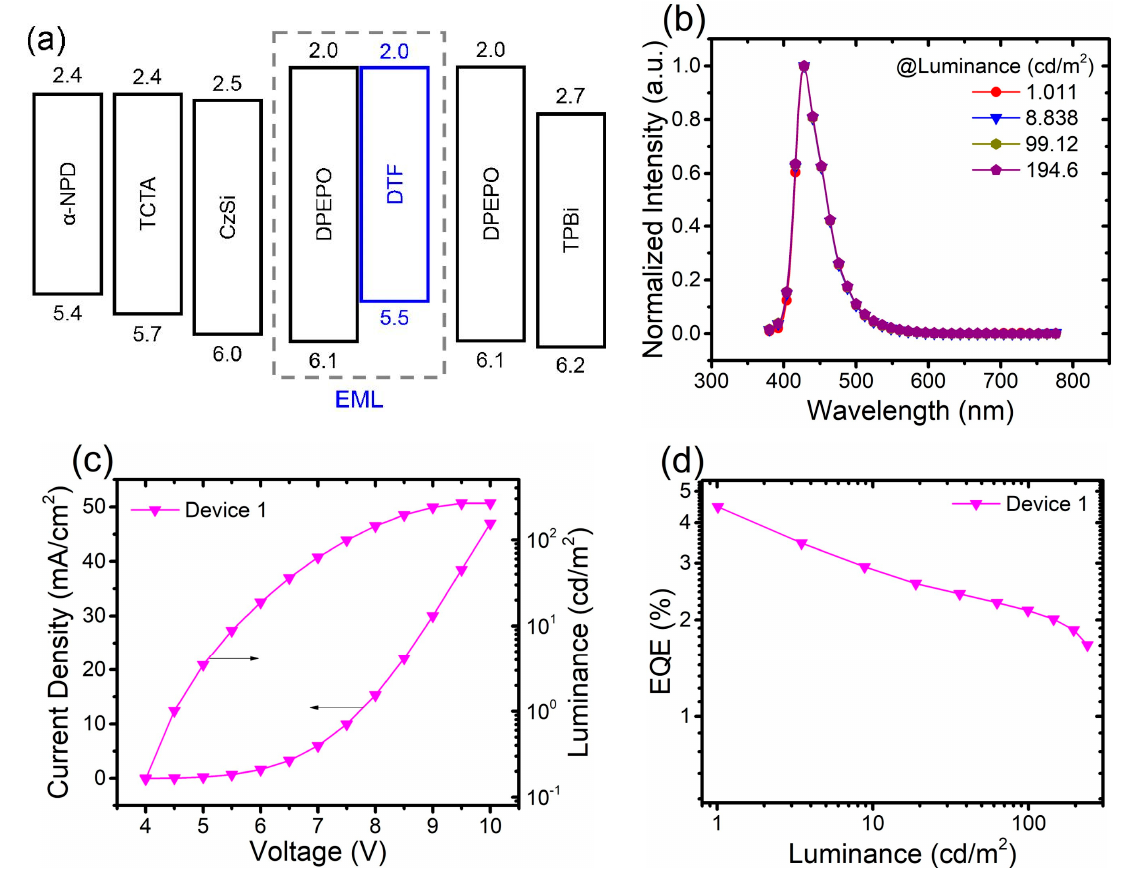
Figure 4. Device 1: ( a ) structure and HOMO, LUMO energy levels (in eV); ( b ) EL spectra; ( c ) current density-voltage-luminance (J-V-L) plots; and ( d ) EQE curve. Table 1. The EL performance summary of the prepared devices in this work.